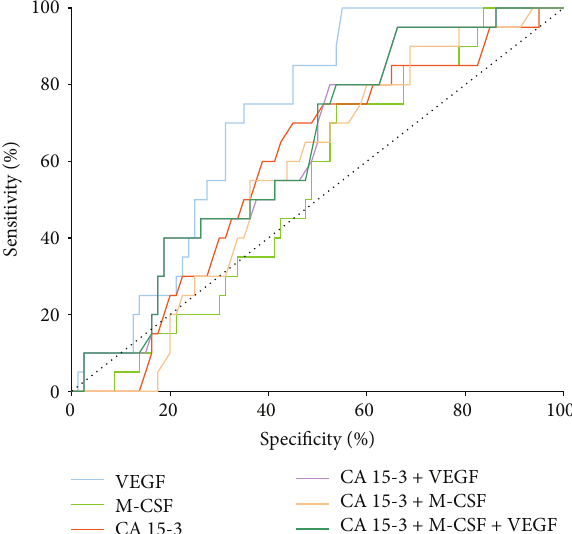
Figure 1: Diagnostic criteria of ROC curve for tested parameters and in combination with CA 15-3 in total BC group.